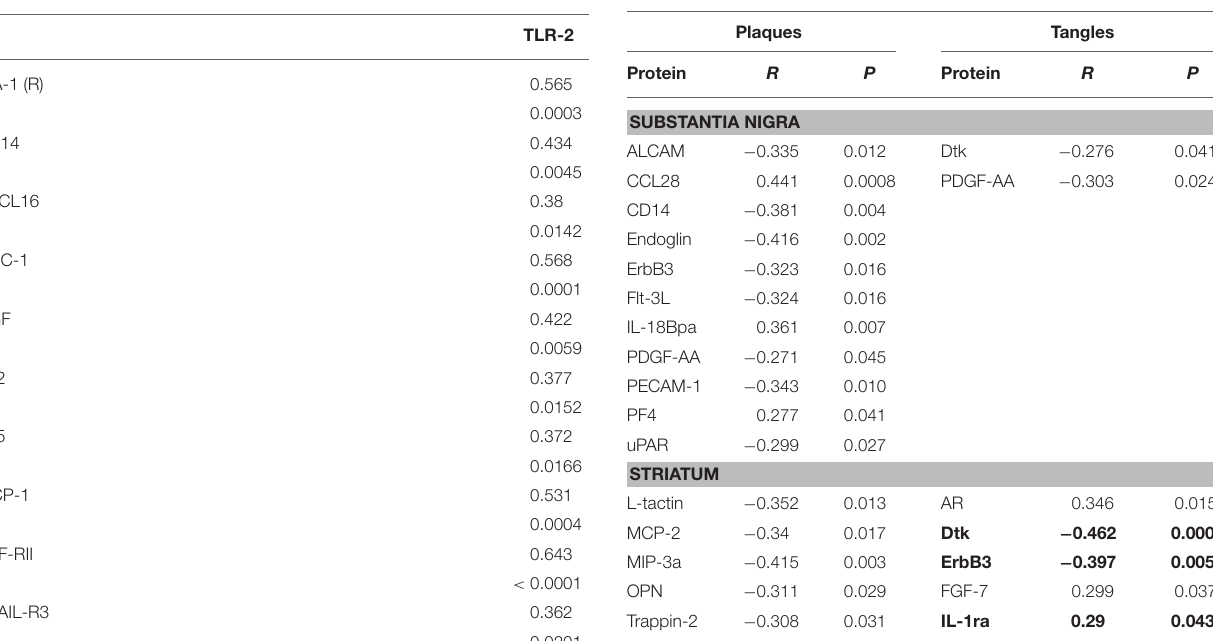
TABLE 8 | Significant correlations between key protein measures and TLR-2 in substantia nigra.